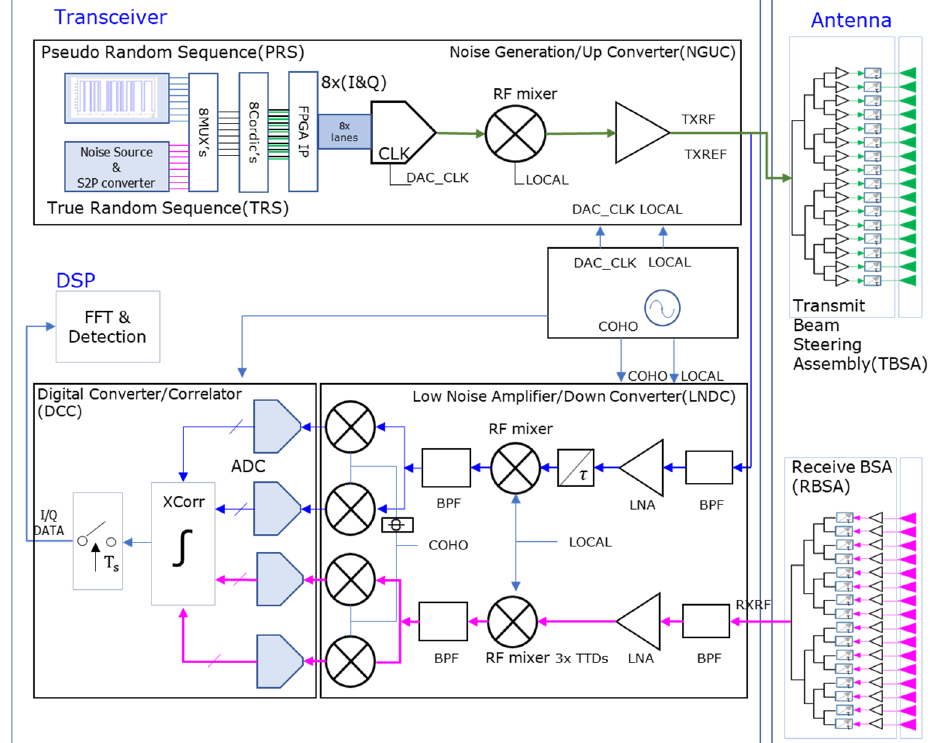
Remote Sens. 2022 , 14 , 4489 13 of 23